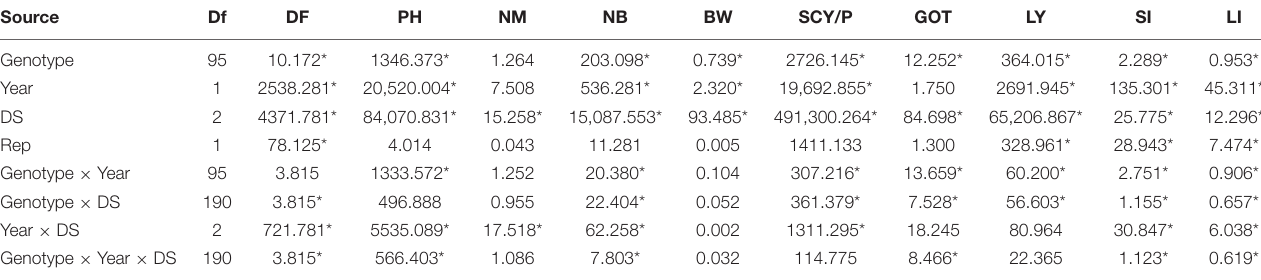
TABLE 1 | Analysis of variance for lint yield and its contributing